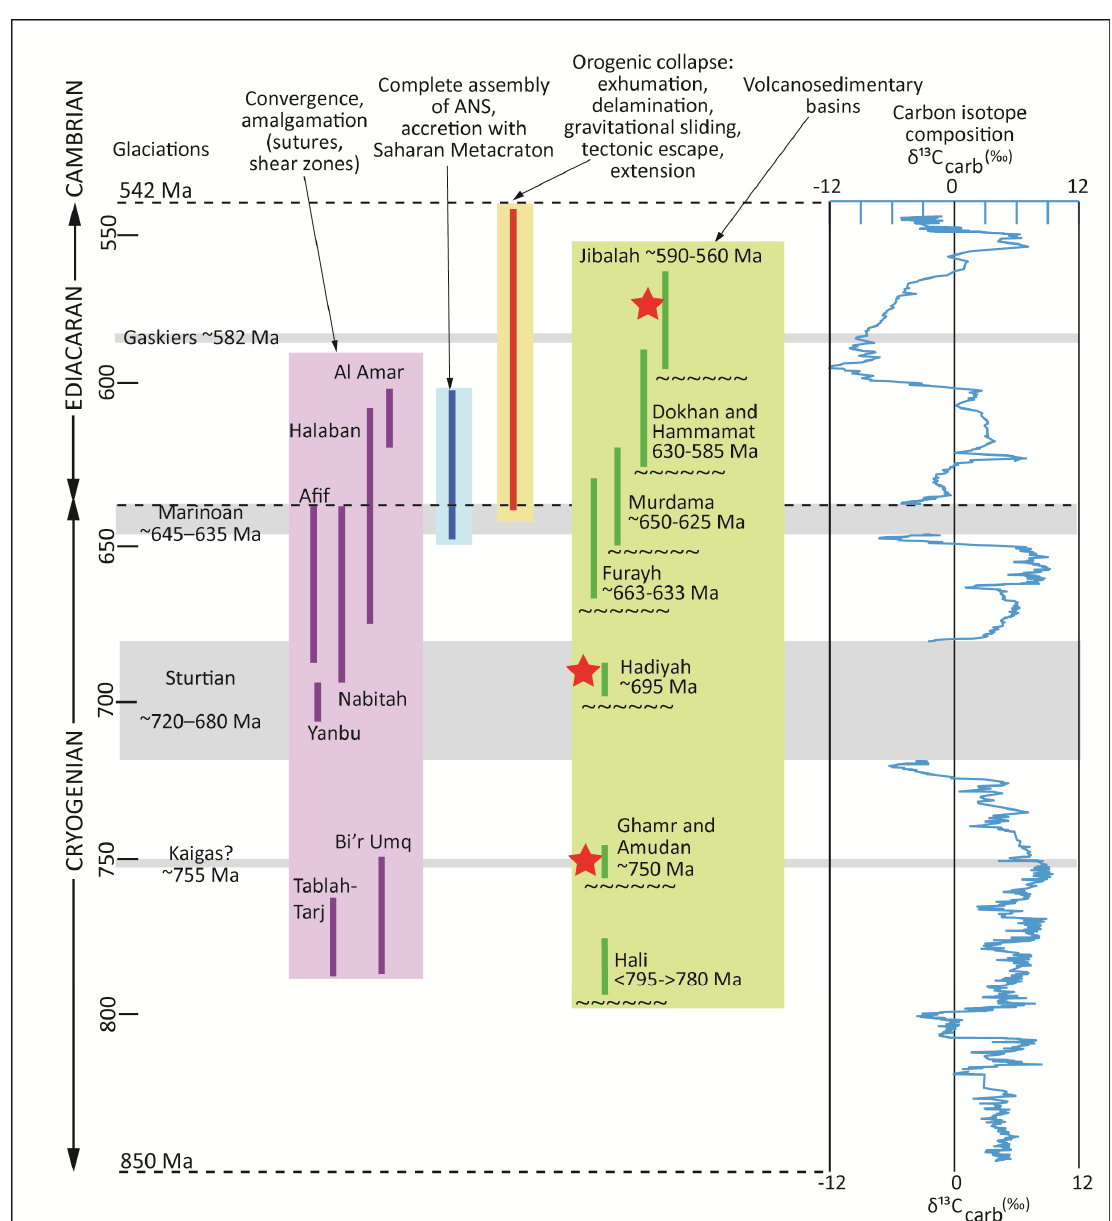
Figure 22. Summary diagram showing temporary relationships between volcanosedimentary basins, glacial intervals, orogenic accretionary events, orogenic collapse events, and secular variation in carbon-isotope composition of shallow-marine carbonates. Timing of glacial events after [41]. See text for discussion of the structural-tectonic features that make up the headings for the two columns labeled “Convergence, amalgamation (sutures, shear zones)” and “Orogenic collapse”. The red stars indicate depositional units that contain diamictite–matrix supported pebbles in the case of the Ghamr and Hadiyah groups, and matrix supported boulders in the case of the Jibalah group. These diamictites are consistent with the timing of glacial events, but are not proven to be glacial deposits. Composite seawater carbon-isotope curve on right modified from